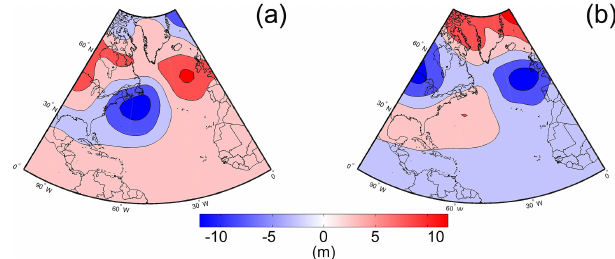
Figure 4. Geopotential at 500hPa anomalies in the Atlantic for win- ter. (a) and (b) correspond to years with positive and negative sum- mer FTLE anomalies, respectively.